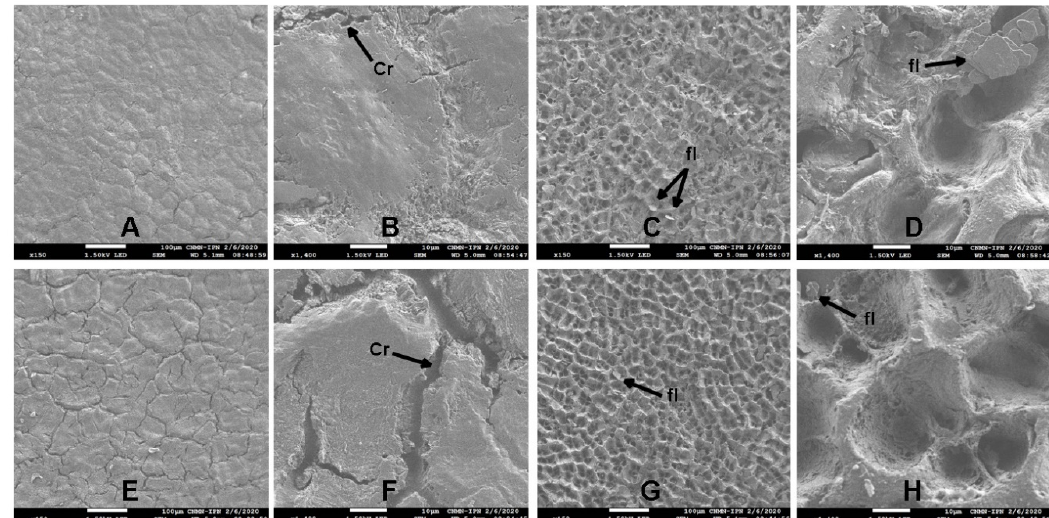
Figure 5. SEM micrographs of cutins from “golden delicious” (( A , B ) outer face and ( C , D ) inner face) and “red” (( E , F ) outer face and ( G , H ) inner face) apples. Cr: cuticular micro-cracks. fl: epicuticular wax flakes.